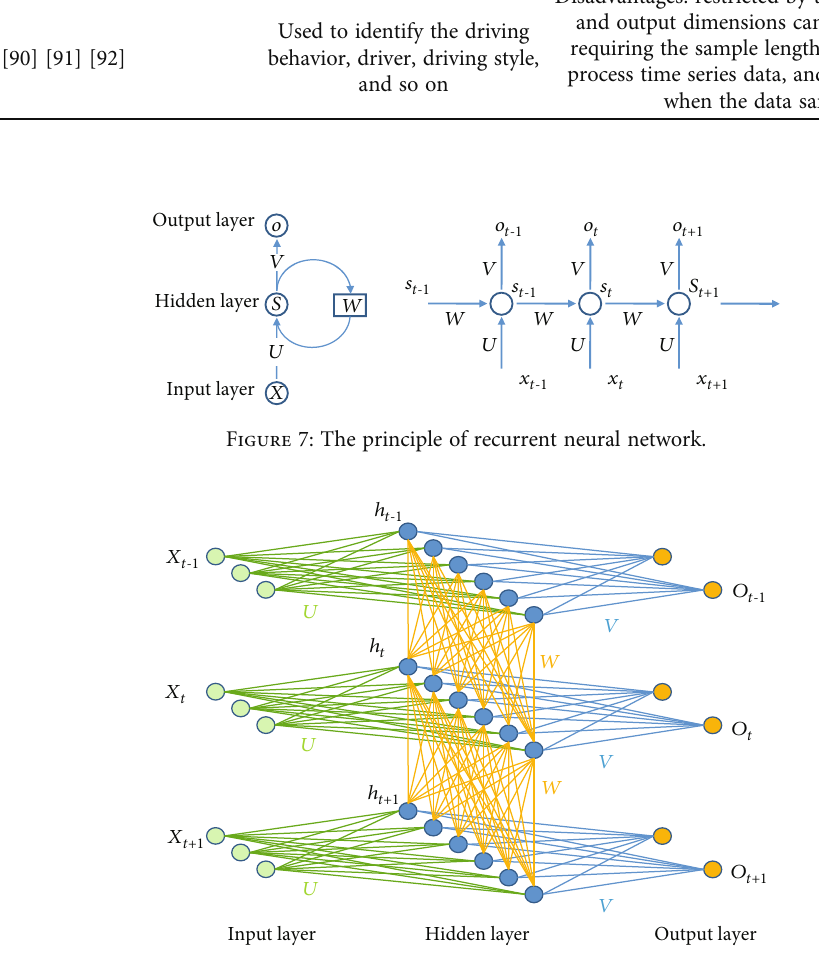
Figure 8: The schematic diagram of RNN neuron